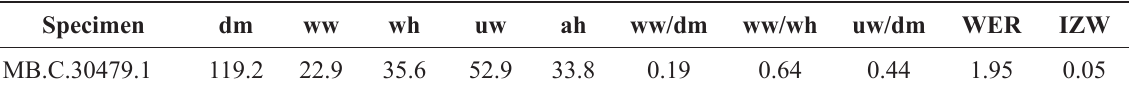
Table 14. Conch dimensions (in mm) and ratios of Aphelaeceras azzelmattiense sp. nov.